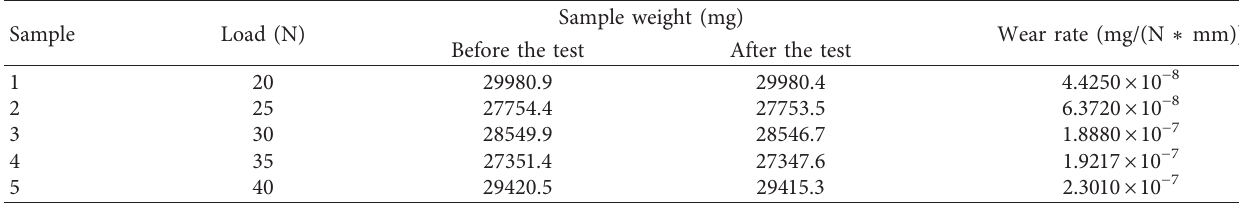
Figure 10: Photographs showing the sample before (a) and after (b) friction tests. Table 4: Sample quality and wear rate.